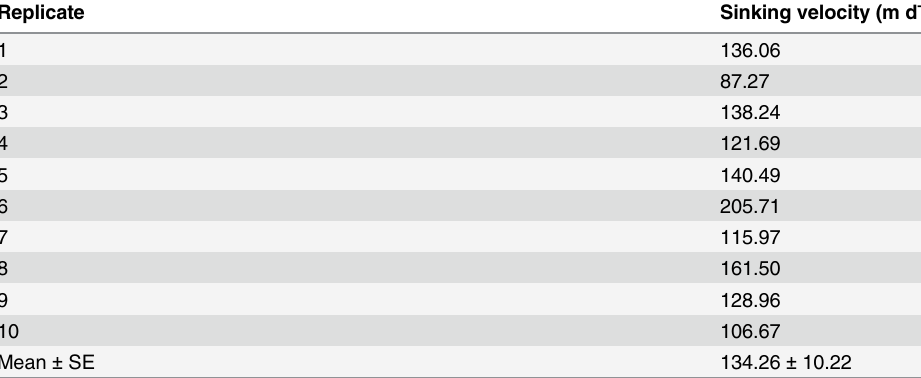
Table 5. In vitro sinking velocity of Bosmina longirostris carcasses measured by settling column method. Replicate